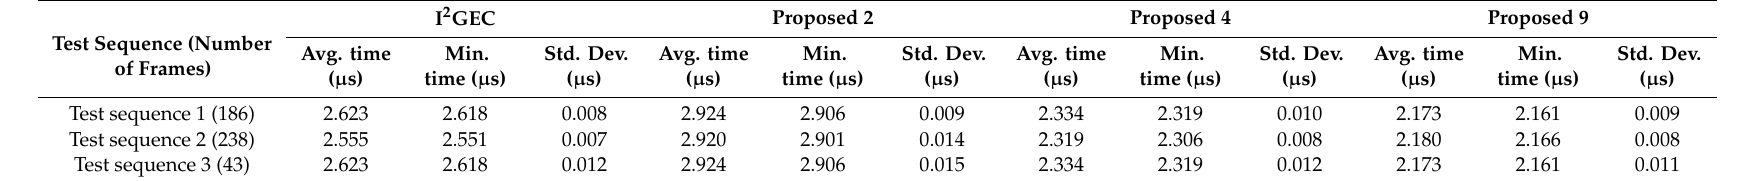
Table 3. Average and minimum computation times for the proposed and benchmark